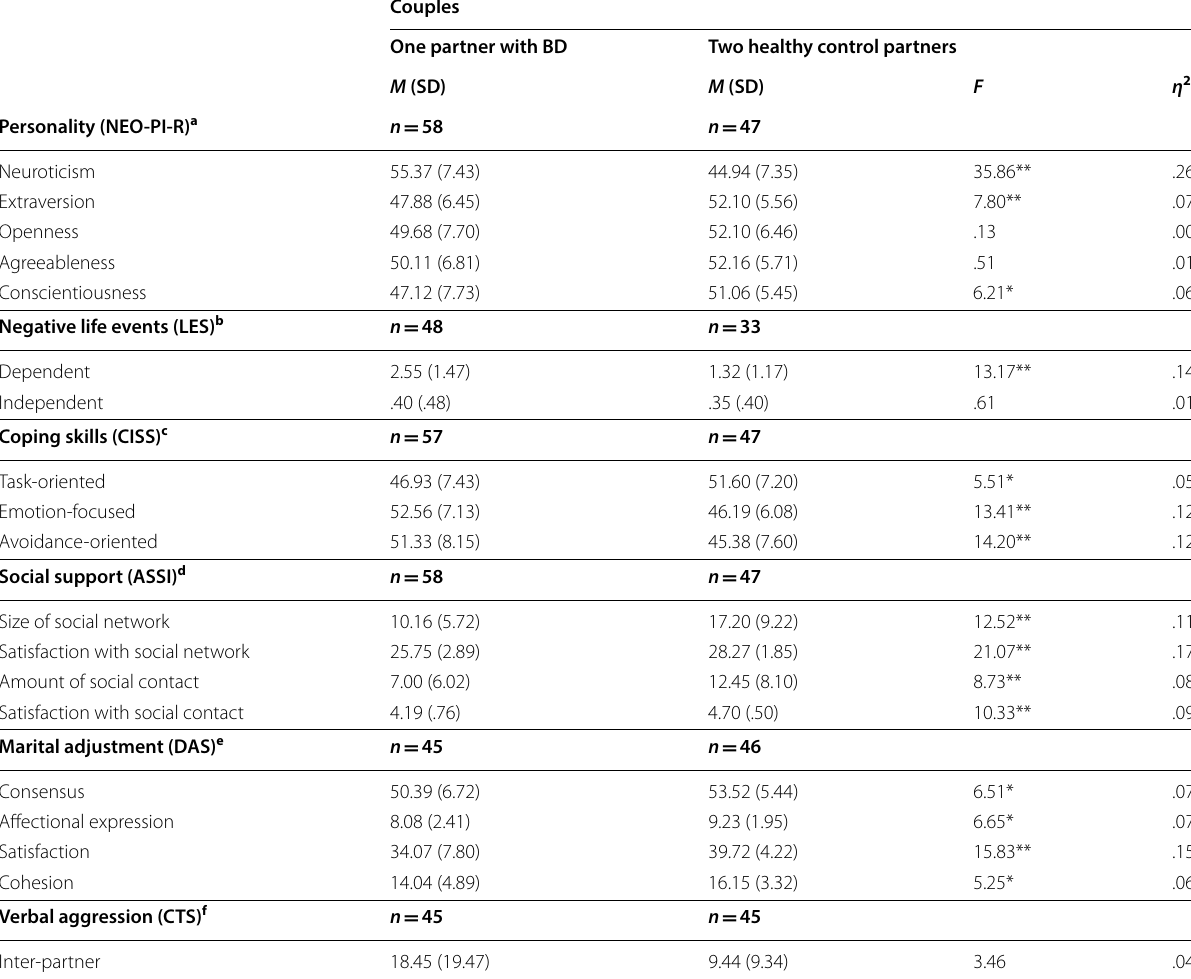
Table 2 Comparisons of personality traits, psychosocial functioning and marital adjustment of couples with and without a partner with bipolar